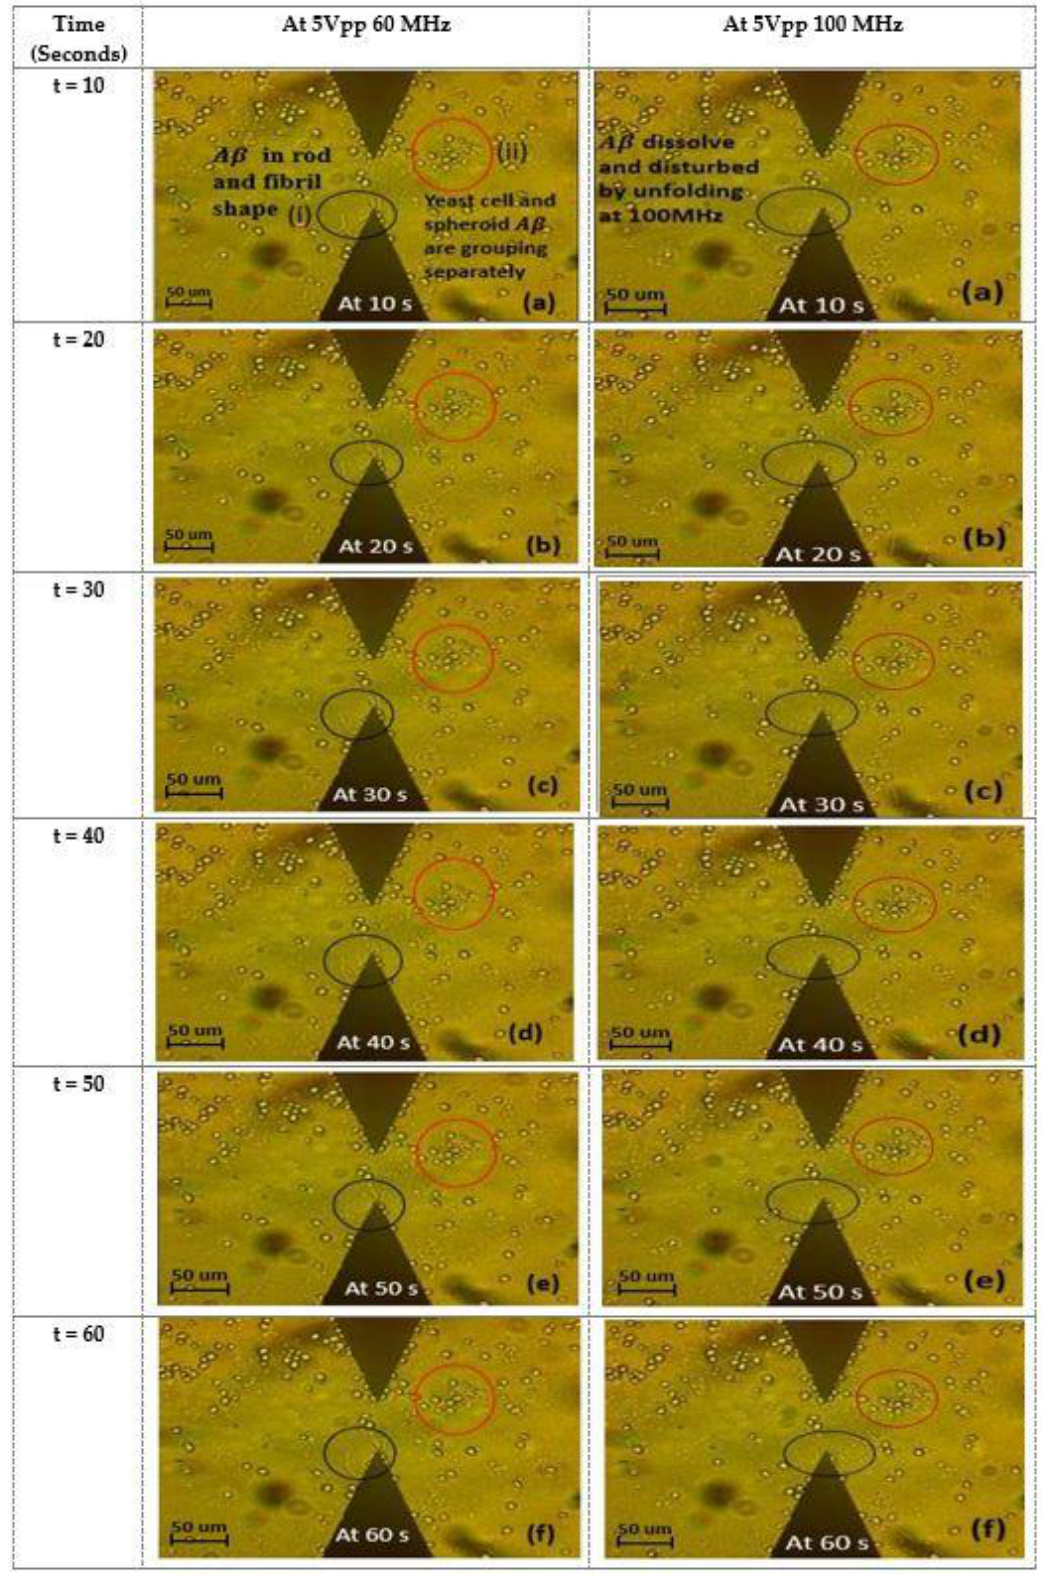
Figure 4. At 5 V pp 60 MHz: ( a ) (i) t = 10 seconds the aggregation of A β to adjacent the electrode Figure 4. At 5 Vpp 60 MHz: (a) (i) t = 10 seconds the aggregation of Aβ to ad jacent the electrode next next to the tip, ( a ) (ii) t = 10 s showing initial separation of the mixture of yeast cells and A β ( b – f ) to the tip, (a) (ii) t = 10 s showing initial separation of the mixture of yeast cells and Aβ (b)– (f) when t when t = 20–60 s there are the same results as in ( a ). At 5 V pp 100 MHz ( a – f ) when t = 10–60 s the A β = 20 – 60 s there are the same results as in (a). At 5 Vpp 100 MHz (a – f) when t = 10 – 60 s the Aβ gradually gradually dissolves by unfolding the A β fibril compared to at 5 V pp 60 dissolves by unf olding the Aβ fibril compared to at 5 Vpp 60 MHz.